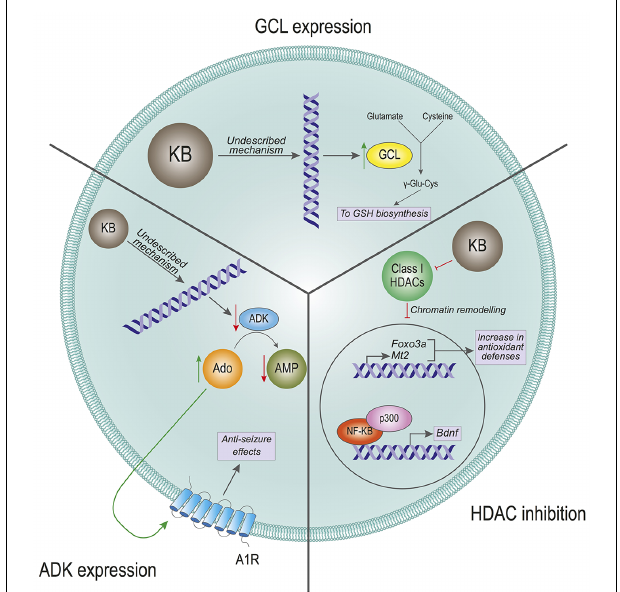
FIGURE 2 | Effects of ketone bodies on gene expression. The proposed mechanisms for the effect of Ketone Bodies (KBs) on gene expression are presented. Glutamate-cysteine ligase (GCL) expression: KBs increase the transcription of the GCL gene, which is the rate-limiting enzyme in the glutathione (GSH) biosynthesis. The incremented expression of GCL increases the levels of GSH, which in turn leads to a rise in antioxidant defenses. HDAC inhibition: KBs are inhibitors of the class I histone deacetylases (HDACs). The inhibition of HDACs provokes a remodeling in the chromatin structure that leads to increased expression of the antioxidant-related genes Foxo3a and Mt2, and to an increased expression of the Bdnf gene mediated by NF- κ B and p300. ADK expression: KBs reduce the expression levels of the adenosine kinase (ADK) gene. This transcriptional inhibition favors high levels of adenosine (Ado) that activate the adenosine 1 receptors (A1R). The activation of these receptors have anti-seizure effects on the cell by reducing firing